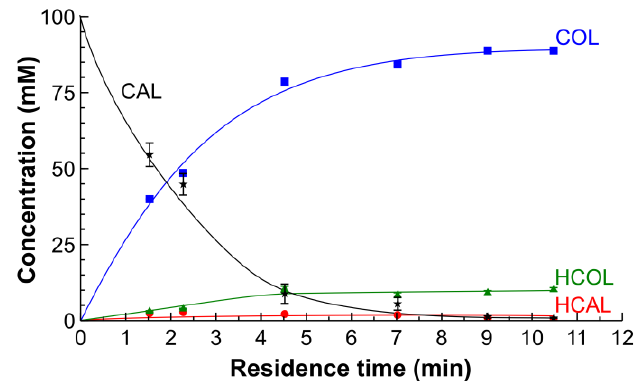
Figure 7. The outlet concentrations of the components obtained in the CAL hydrogenation as a function of residence time in the 5 m reactor coated with 190 mg 12 wt % Pt/SiO 2 catalyst. Reaction conditions: H 2 flow rate: 4–12 mL min −1 (standard temperature and pressure, STP), liquid flow rate: 0.2–3 mL min −1 , inlet CAL concentration: 0.1 M in IPA, pressure: 10 bar, temperature: 90 °C.